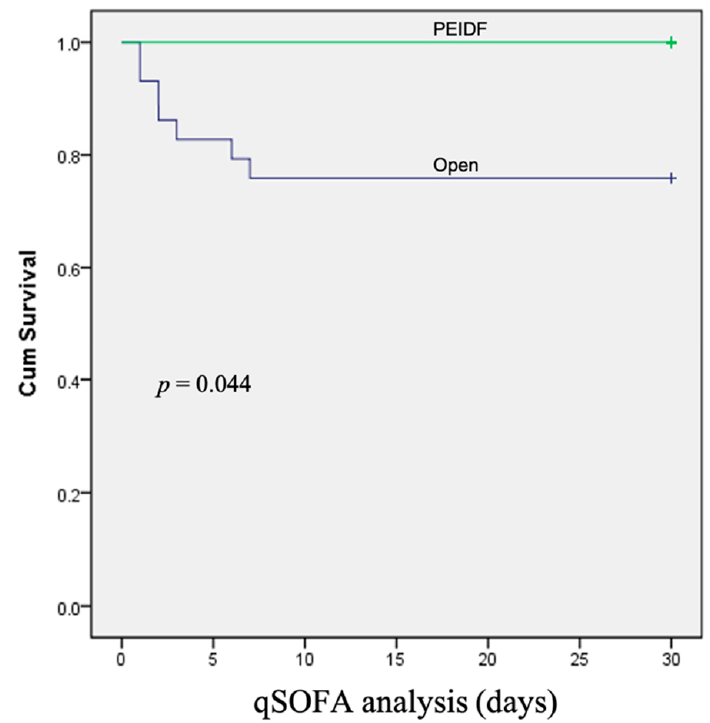
Figure 4. The Kaplan–Meier curve shows that patients receiving conventional open surgery had a higher rate of a qSOFA of ≥ 2 within one month after surgery.